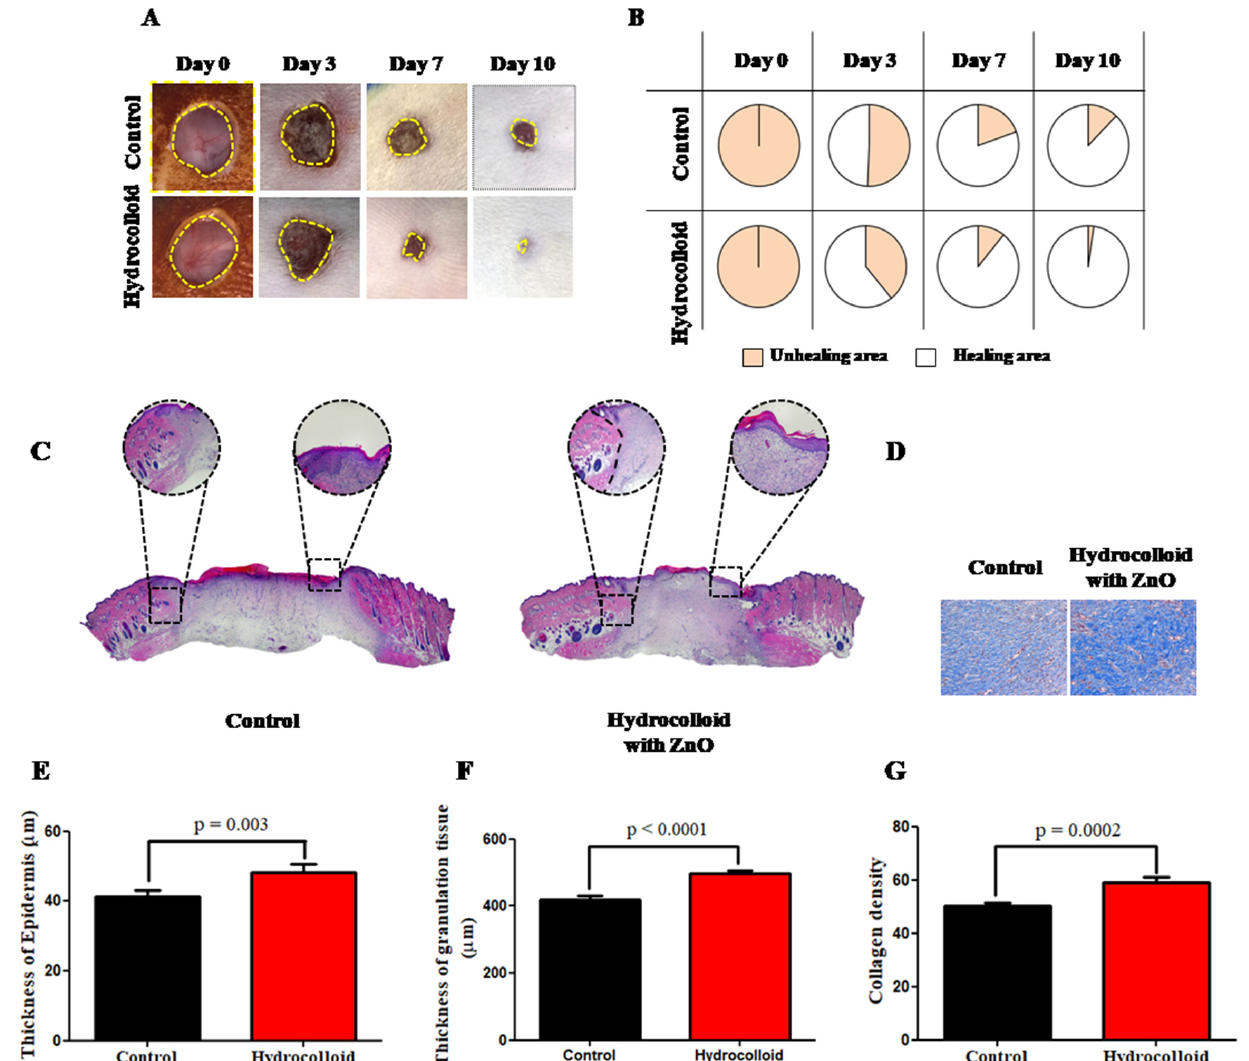
Figure 1. A hydrocolloid patch covered with ZnO-NPs accelerates wound healing on both macro- scopic and microscopic scales. ( A ) Representative images (1× magnification) of the wound of the hydrocolloid-with-ZnO-NPs patch and the control group throughout the healing process. ( B ) Wound healing closure rates of these two groups. The rates presented as a percentage of the initial wound area on day 0. ( C ) 4× magnification images of H&E staining on day 10 after treatment with a hydrocolloid patch covered with ZnO-NPs and without treatment. ( D ) 10× magnification images of MT staining on day 10. The blue color indicates the distribution of the collagen. ( E ) Quantified epidermis thickness gap on day 10. ( F ) Quantified granulation tissue gap on day 10. ( G ) Quantified collagen density on day 10.